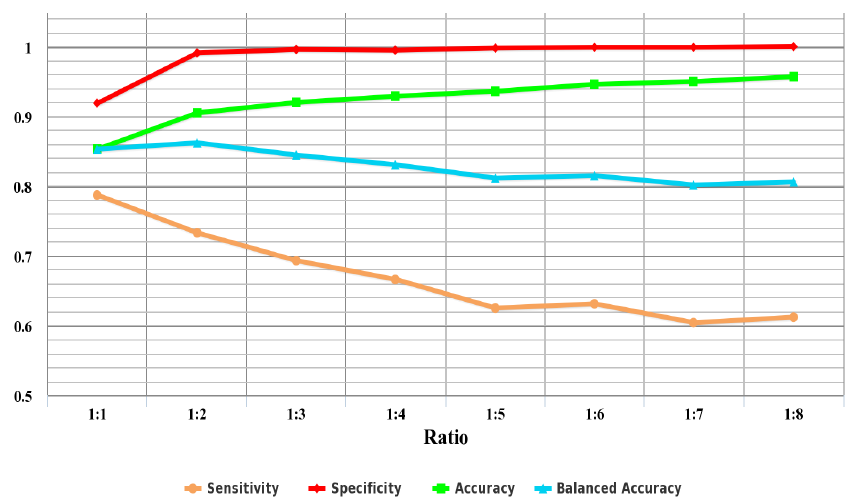
Figure 6. The performance with different ratios between positive and negative samples in the training set without random sampling. The ratios of the number of positive samples to negative ones are from 1:1 to 1:8,